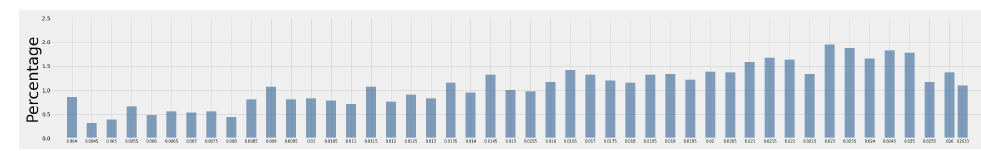
Figure 2: Bias Distribution for approach from [AFK + 08] for ID ∆ (0)